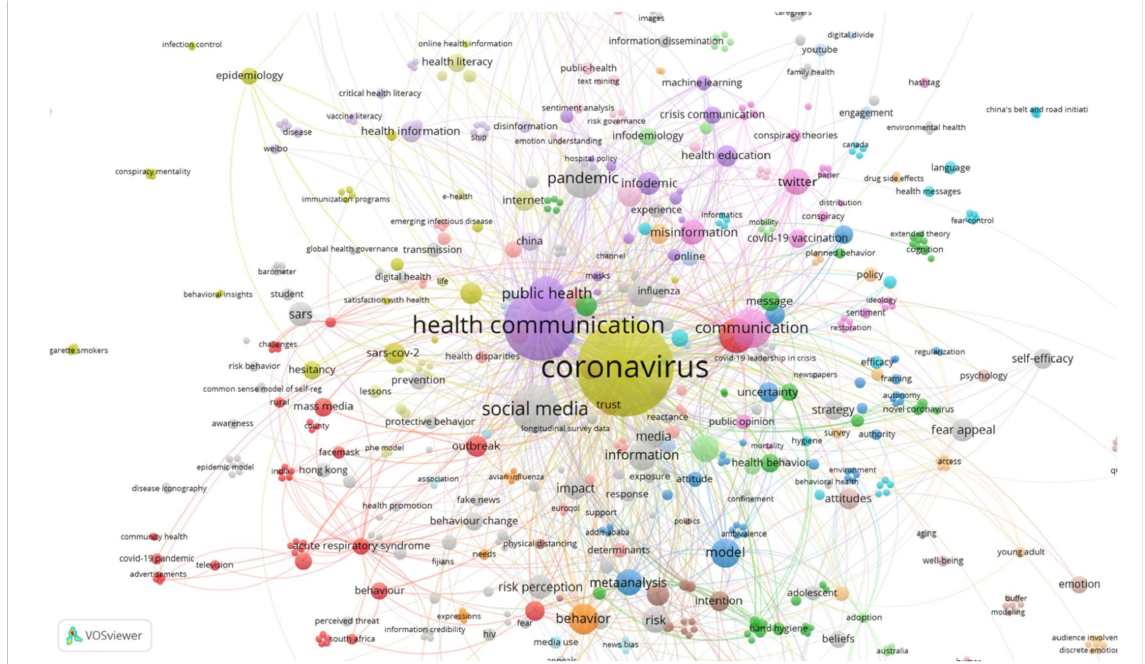
Figure 8. Co-occurrence map for the years 2020 and 2021.